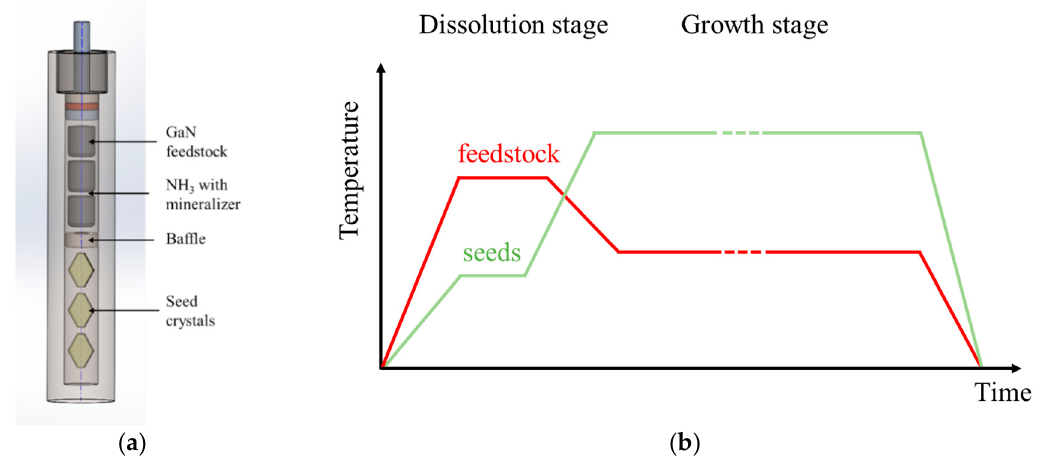
Figure 5. Scheme of: ( a ) high pressure ammonothermal autoclave; ( b ) temperature-time profiles of feedstock (red curve) and crystal growth zones (green curve) during a typical ammonothermal crystallization process at IHPP PAS.